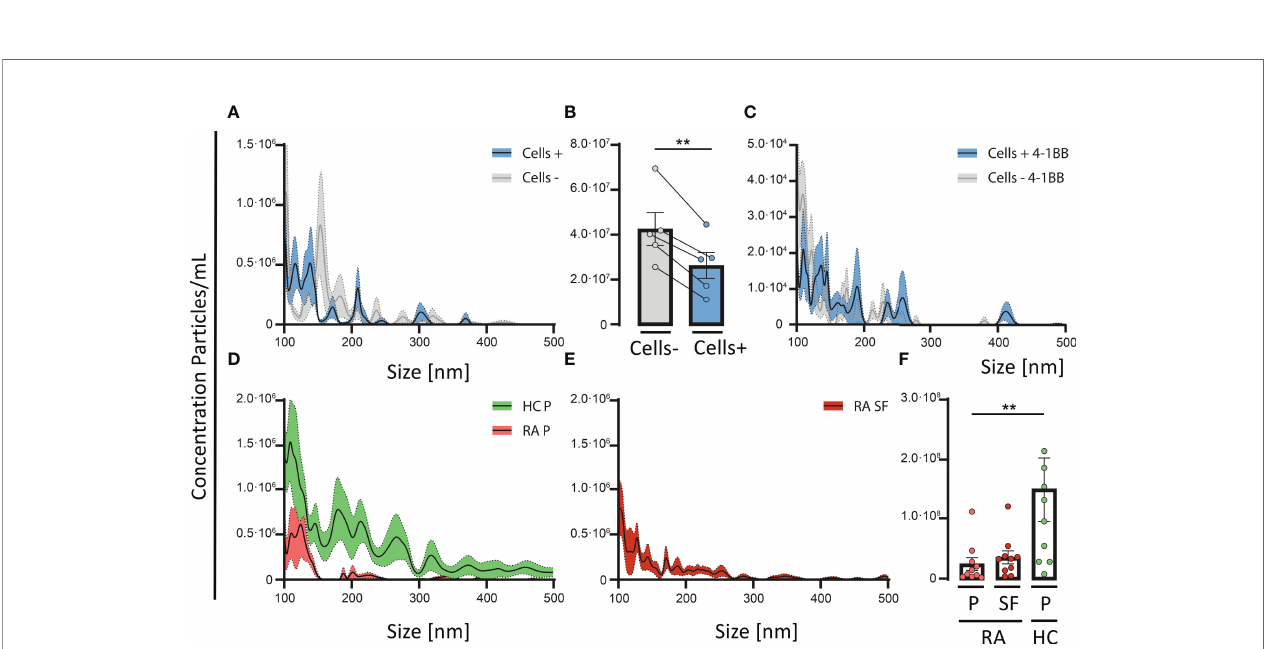
FIGURE 3 | 4-1BB positive T cells are involved in the depletion of soluble Gal-3 complexes. Normal human plasma was incubated with, or without, CD3/CD28-activated CD4 T-cells for 30 minutes at 37°C, followed by detection of Gal-3 positive particles measured by nanoparticle tracking analyses. (A) Activated CD4 T-cells (n = 5) resulted in a depletion of Gal-3 positive particles, especially with a diameter < 200nm. (B) CD3/CD28-activated CD4 T-cells (n = 5) incubated with plasma from healthy controls (HC) resulted in a signi fi cant reduction of Gal-3 positive particles compared with plasma not encountering activated T cells. (A, B) Data are expressed as mean ± SEM, Student ’ s paired t-test, **P < 0.01. (C) In a similar setup, plasma from HC were incubated for 30 minutes at 37°C, with 4-1BB transfected HEK293 cells (4- 1BB + HEK293) and wild type (HEK293) (n = 5, HC plasma samples). 4-1BB + HEK293 cells depleted Gal-3 particles from plasma, more than wild type cells, primarily of complexes < 200 nm in size. (D) Comparing the distribution of Gal-3 positive particles in plasma from HC (Green, n = 10) and rheumatoid arthritis (Red, n = 10) the number of Gal-3 particles were decreased in RA plasma. (E) RA synovial fl uid (n = 10) showed a similar pattern of Gal-3 positive particles as seen in RA plasma. (F) The total number of Gal-3 complexes were signi fi cantly decreased in RA plasma compared with HC plasma, **P < 0.01 (unpaired t-test). Data are expressed as mean ± SEM, unpaired Student ’ s t-test.